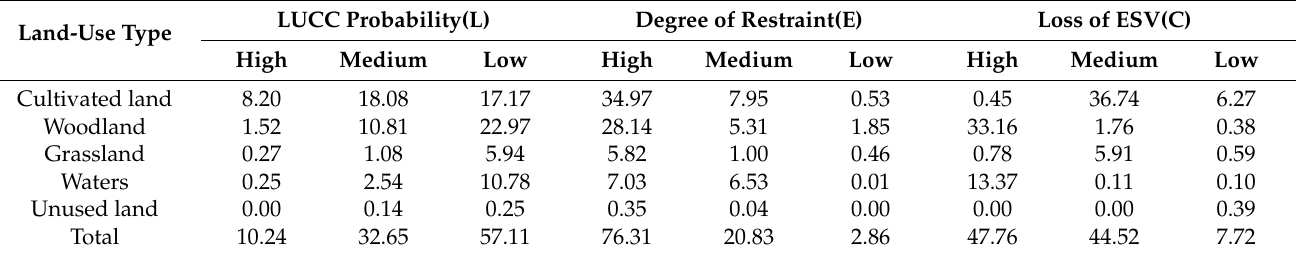
Table 2. LEC parameter classification and area percentage (%).